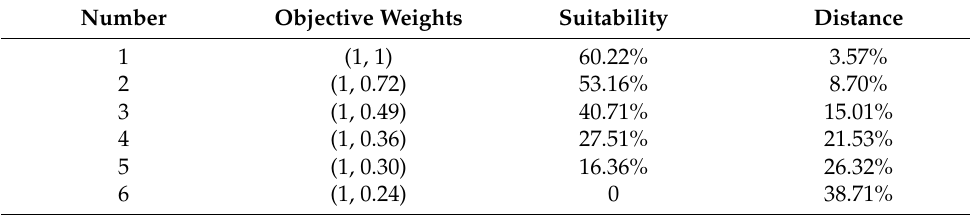
Table 17. Deviations in different solutions in the first stage.